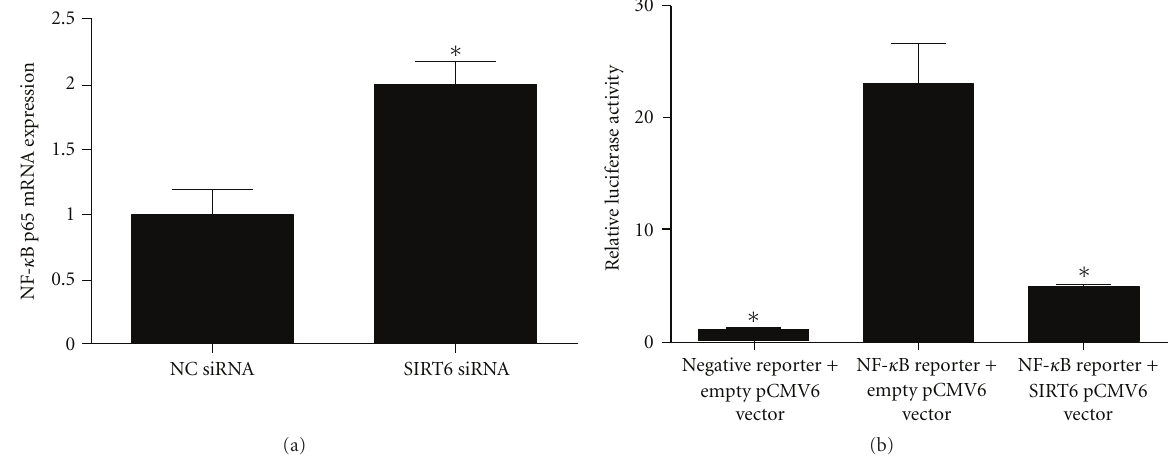
Figure 8: SIRT6 regulates inflammation via NF- κ B. (a) HUVECs were transfected with 50nM SIRT6 or NS siRNA for 96h ( n = 6). NF- κ B p65 mRNA expression was quantified by qRT-PCR. Each bar represents the mean ± SEM. ∗ P < 0 . 05 versus NS siRNA transfected cells. (b) HUVECs were cotransfected with 1 μ g negative control construct and NF- κ B reporter construct, along with 1 μ g empty or SIRT6 pCMV6 vector for 72 h. Promoter activity is expressed as a ratio of luciferase activity of the control group, which was set as 1. Each bar represents the mean ± SEM ( n = 3 experiments). ∗ P < 0 . 05 versus cells transfected with NF- κ B reporter plus empty pCMV6 vector.